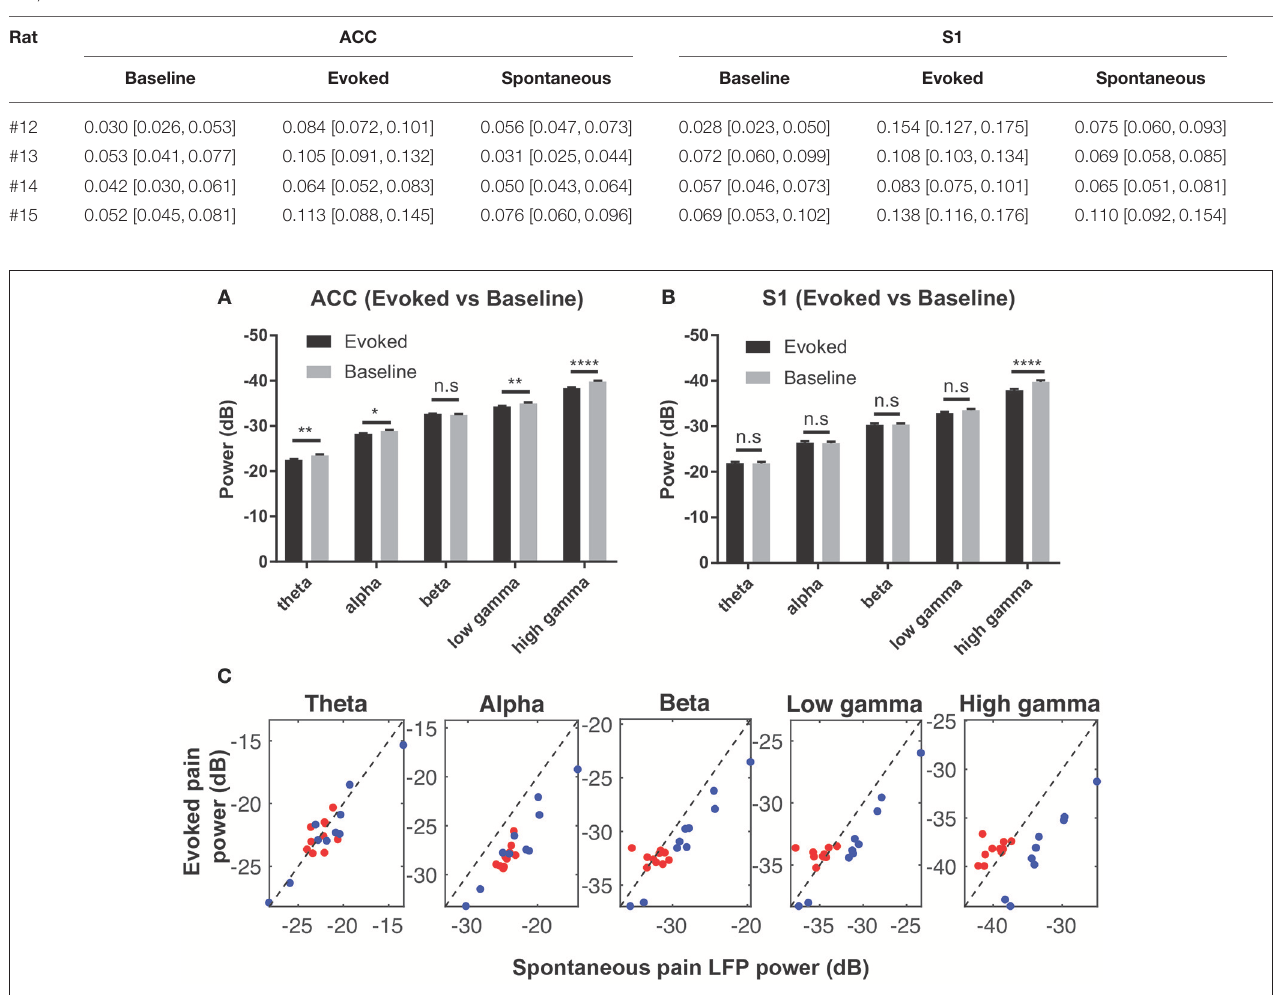
FIGURE 4 | (A) Comparison of the mean LFP power between evoked pain and baseline at various frequency bands in the ACC (A) and S1 (B) (rats #12–15, n trials). Note that the y-axis shows the negative value in dB. ∗ p < 0.05; ∗∗ p < 0.01, ∗∗∗∗ p < 0.0001, paired t -test. (C) Mean LFP power comparison between the evoked and spontaneous pain-like episodes (ACC: red; S1: blue; rats #12–15, n